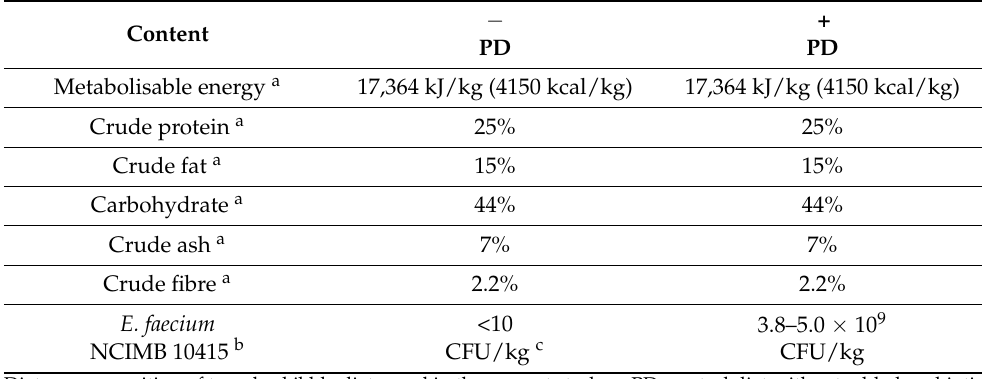
Table 1. Nutritional composition of study